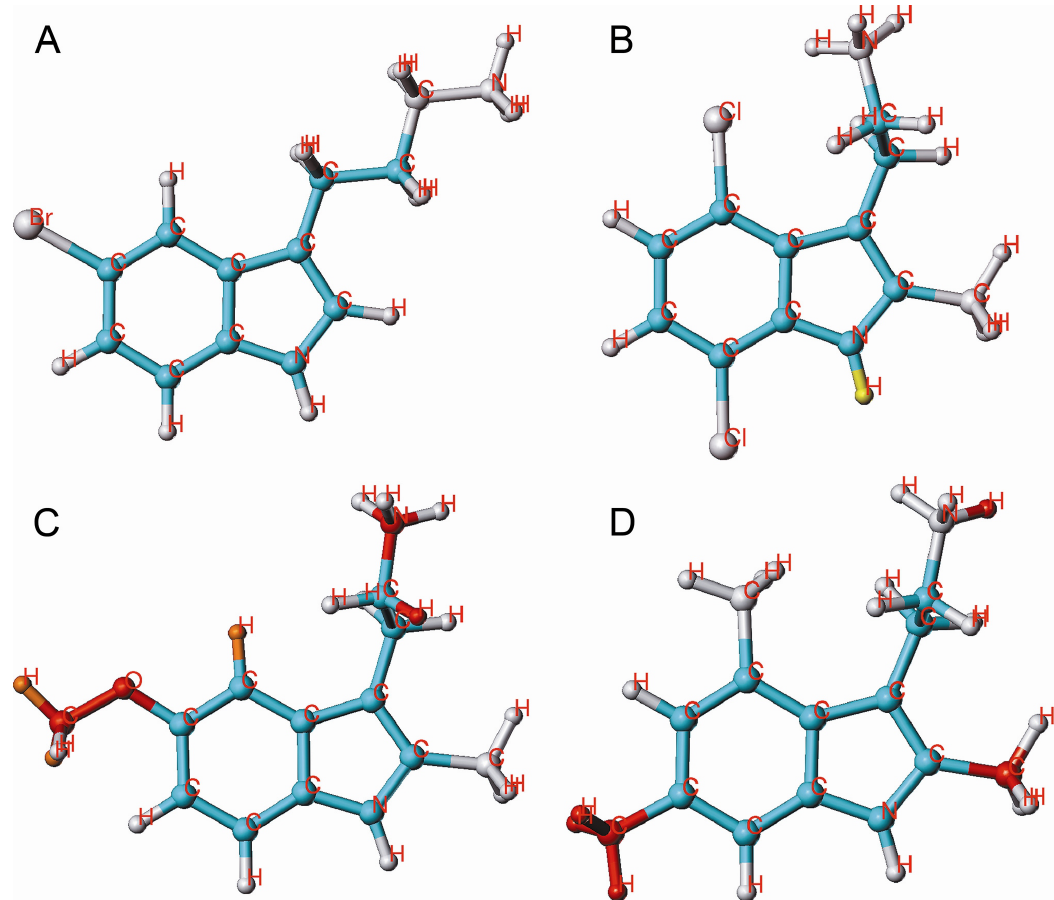
Figure 4. HQSAR contribution of molecular fragments to the inhibition of [ 3 H]ketanserin binding; 2 examples for highly active compounds 14 ( A ) and 53 ( B ) and 2 examples for weak compounds, 29 ( C ) and 42 ( D ) are